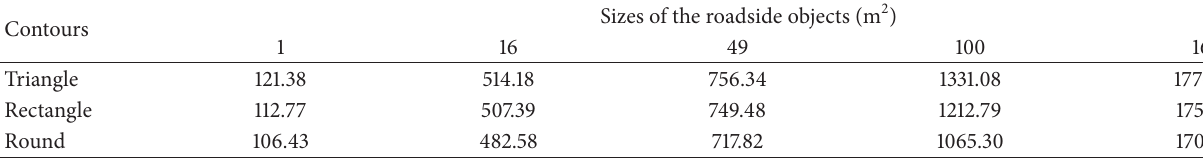
Table 5: The mean legibility distance under 120km/h.